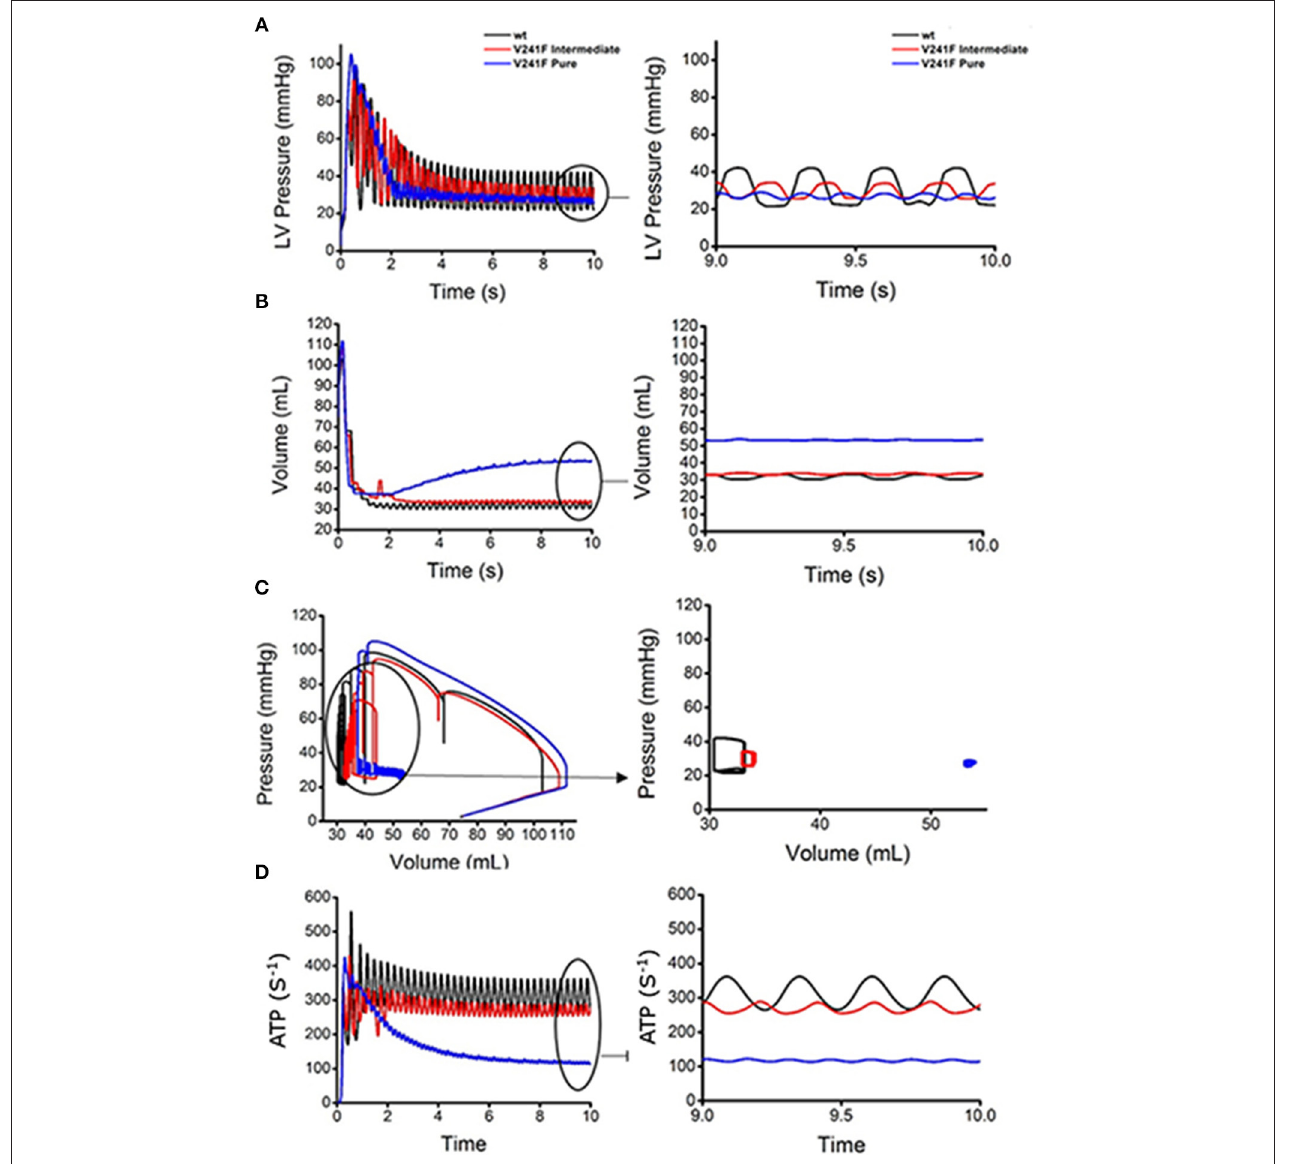
FIGURE 6 | Ventricular mechanical responses of reentrant dynamics wave in the 3D ventricular tissue model for WT, V241F intermediate and pure condition. (A) LV pressure waveforms, (B) LV volume waveforms, (C) LV pressure-volume curves and (D) ATP curves for WT, V241F Intermediate, and Pure mutation